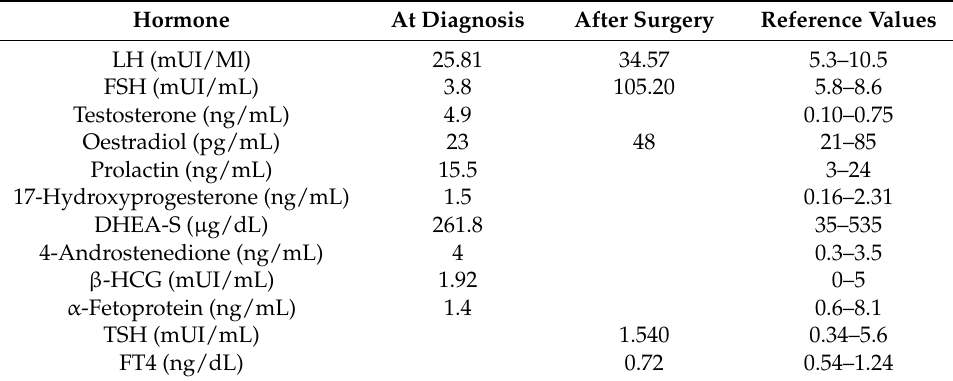
Table 2. Serum hormone concentrations in Patient 2 at diagnosis and after